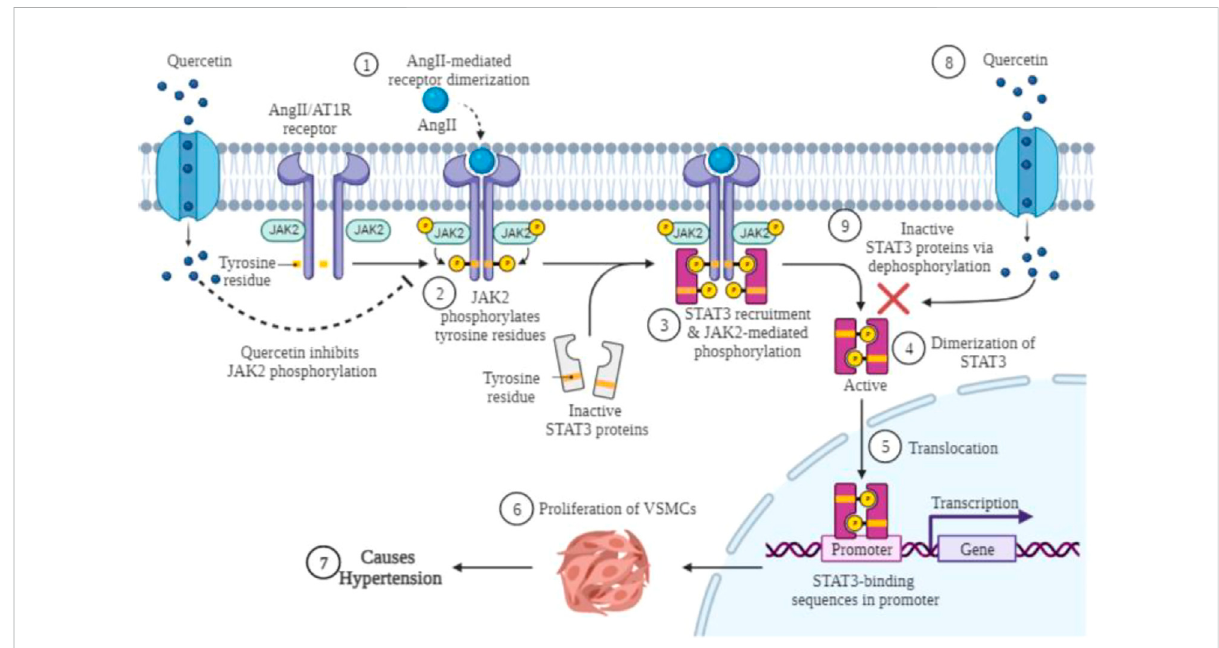
FIGURE 7 Graphical presentation of anti-proliferative effect of quercetin along with inhibition of JAK/STAT activation in VSMCs. AngII binds to the angiotensin II type 1 receptor (AT1R), which mediates phosphorylation of JAK2, and phosphorylated JAK2 activates the inactivated form of STAT3 by phosphorylation of tyrosine residues. The phosphorylated complex activated by JAK2 and STAT3 assists STAT3 in dimerization. After dimerization of STAT3protein,itistranslocatedtothenucleus,whereitbindstothegenepromoter,andthealteredproteinexpressionmayleadtoproliferation ofVSMCsandconsequentlyhypertension.QuercetintreatmentinactivatestheactivatedformofJAK2andSTAT3bydephosphorylationaswellasby blocking the dimerization of both proteins. Created with